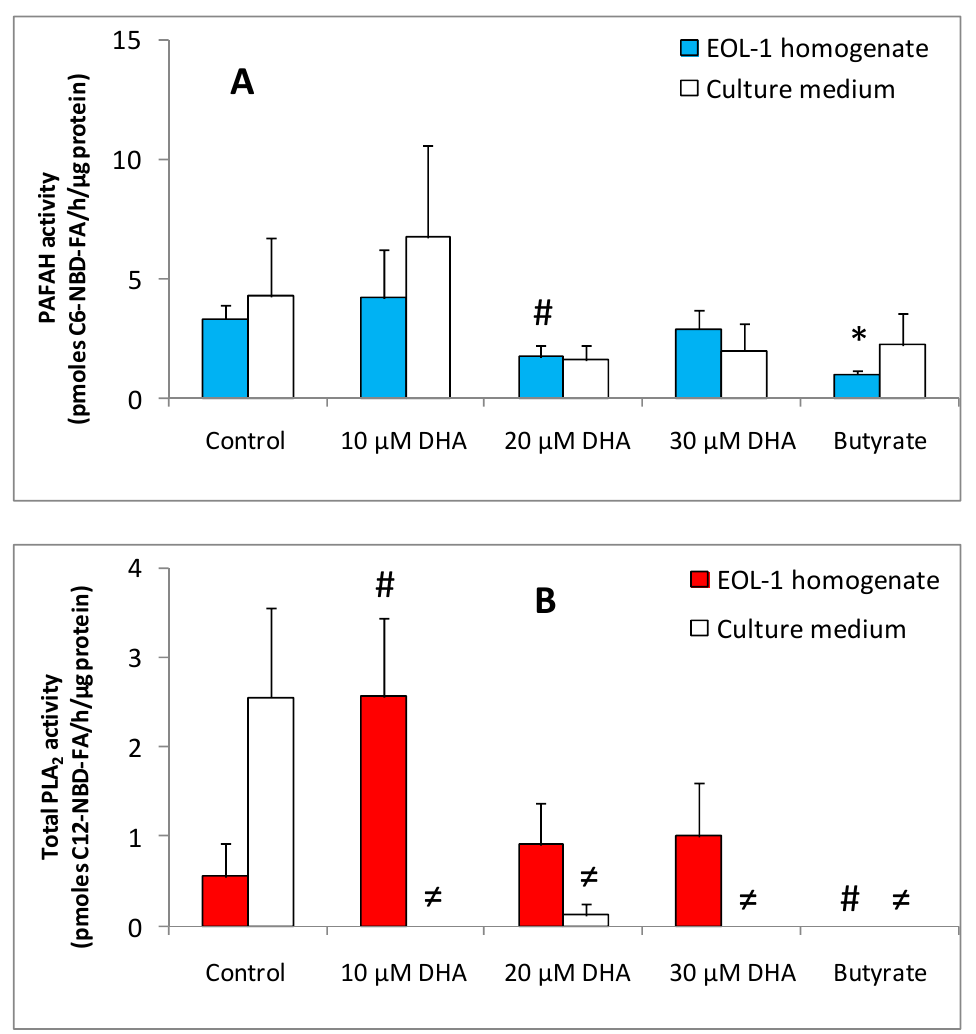
Figure 6. Effect of DHA treatment upon PAFAH (PAF-Acetylhydrolase) and PLA 2 enzymatic activities of EoL-1 cells. ( A ) PAFAH activities of EoL-1 homogenates and supernatant of 3 days treated (10 µ M DHA or 500 µ M butyrate) and untreated cells ( n = 3, in duplicates). ( B ) PLA 2 activities of EoL-1 homogenates and supernatant of 3 days treated (10 µ M DHA or 500 µ M butyrate) and untreated cells ( n = 3, in duplicates). PLA 2 activity was not detectable in culture medium at 10, 30 µ M DHA and in butyrate. The symbols # and (cid:54) = denotes statistically significant differences of p < 0.05 for homogenates and culture medium, respectively, versus control. * denote statistical significant difference of p < 0.01 as compared to control. t -Test analysis for independent samples was applied by Statistica